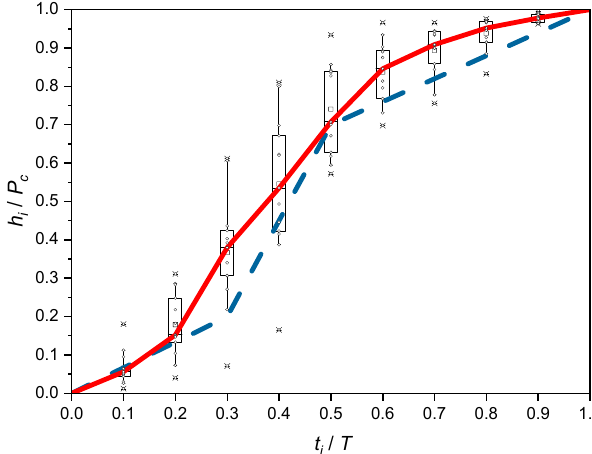
Figure 11. Box plot hyetograph of 10 frontal and three low-pressure precipitation (solid line) together with the DVWK pattern (dashed line).